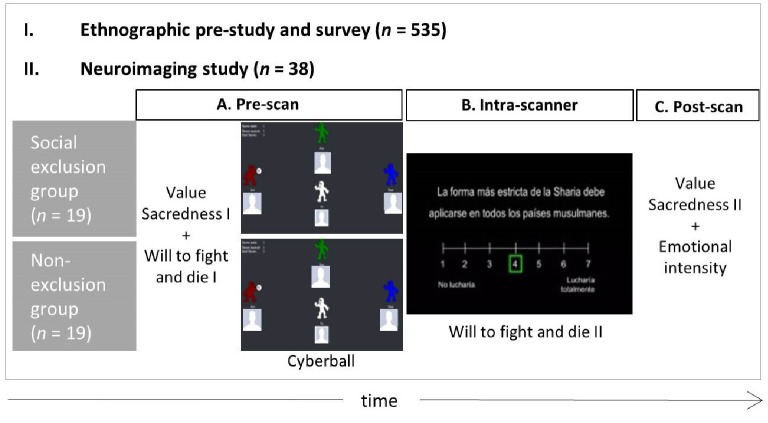
Scheme of the testing timeline consisting of (I) the ethnographic prestudy and survey and (II) the neuroimaging study including (A) a prescan behavioral testing session (around 45 min) including sacred value selection by rejection of material tradeoff, the premanipulation will to fight and die measure for sacred and nonsacred values, and the Cyberball experimental manipulation in either the social exclusion or the non-exclusion condition (between-subjects factor), (B) an intrascanner session (around 20 min) including a postmanipulation will to fight and die measure for sacred and nonsacred values, and (C) a postscan behavioral session (around 45 min) including sacredness reassessment of nonsacred values by rejection of material trade-off and emotional intensity scores at the thought of defending each value.